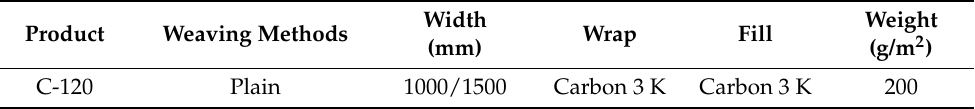
Figure 1. Plain carbon fabric. Table 1. Specification of carbon fabrics.